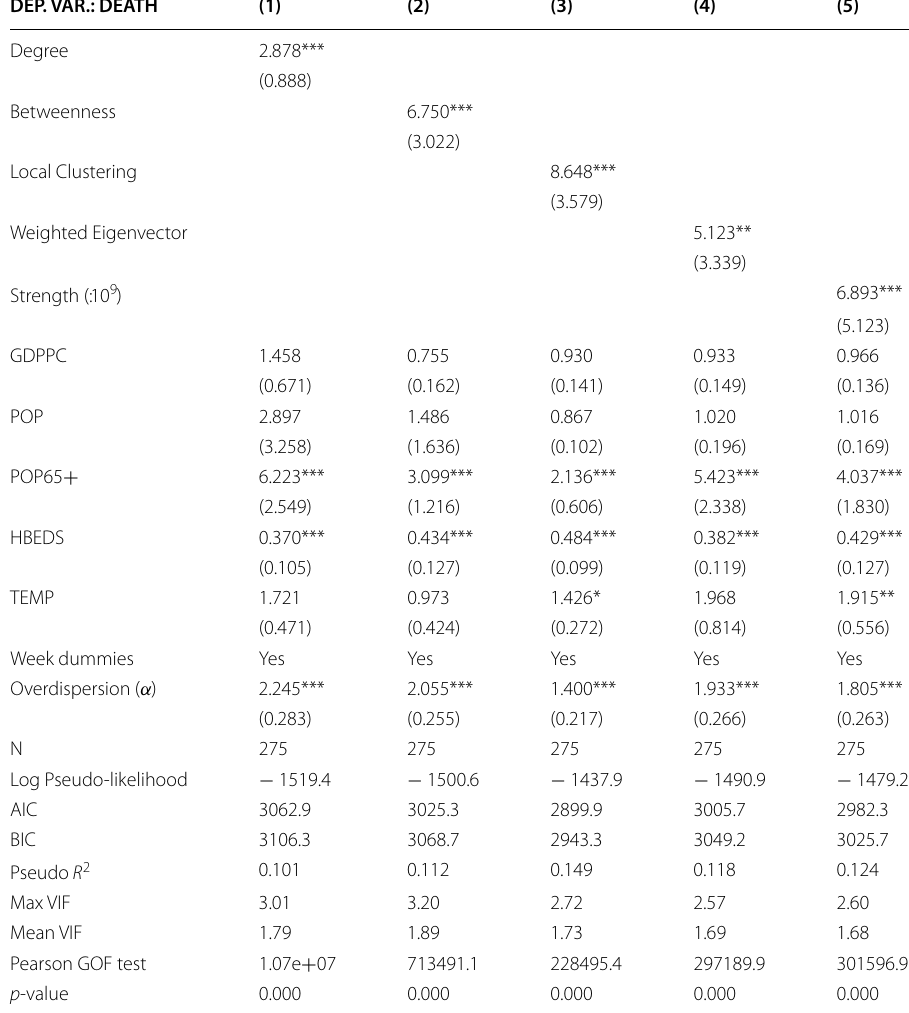
Country‑level clustered standard errors in